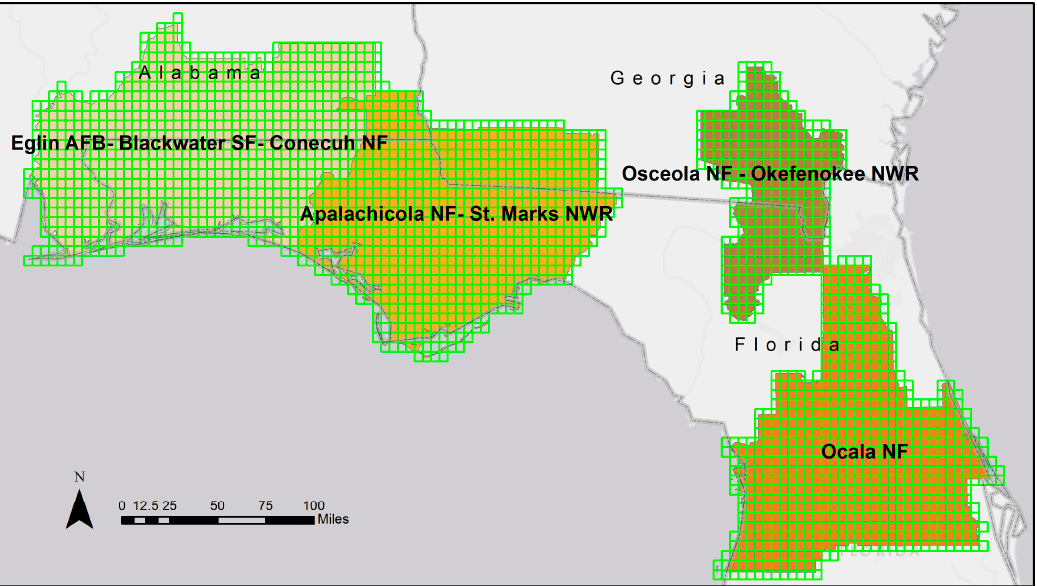
Figure 1. The four significant geographic areas (SGA) that are included in our study area along with the grid of overlapping National Agriculture Imagery Program (NAIP) digital orthophoto quarter quad (DOQQ) tiles.